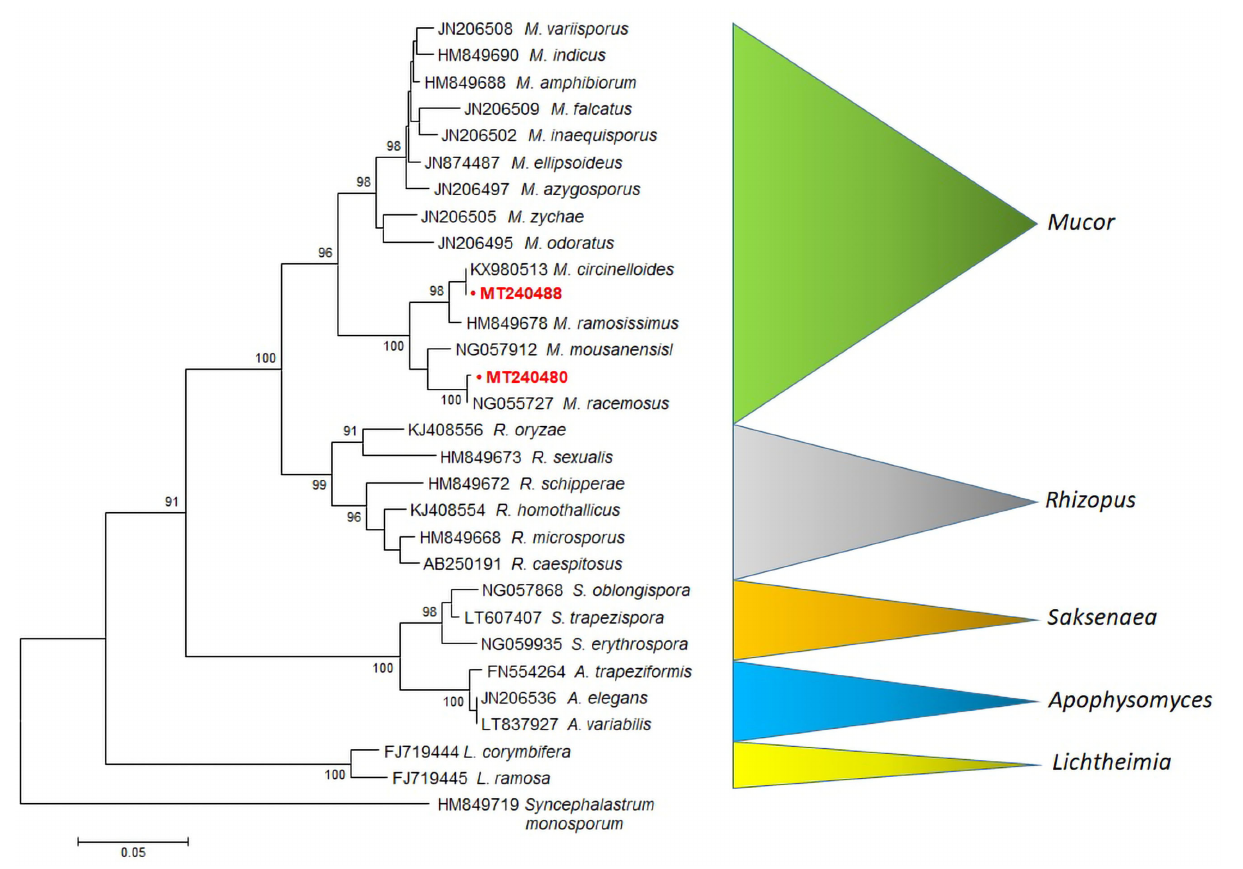
FIGURE 2 | MEGA6 neighbor-joining tree of the Mucorales and related species ( Mucor , Rhizopus , Saksenaea , Apophysomyces and Lichtheimia ) based on LSU sequences (28S rRNA). Bootstrap values shown at the main nodes represent the probabilities based on 1,000 replicates. Sequence of Syncephalastrum monosporum was used as an outgroup. The sequences produced by our study are highlighted in bold